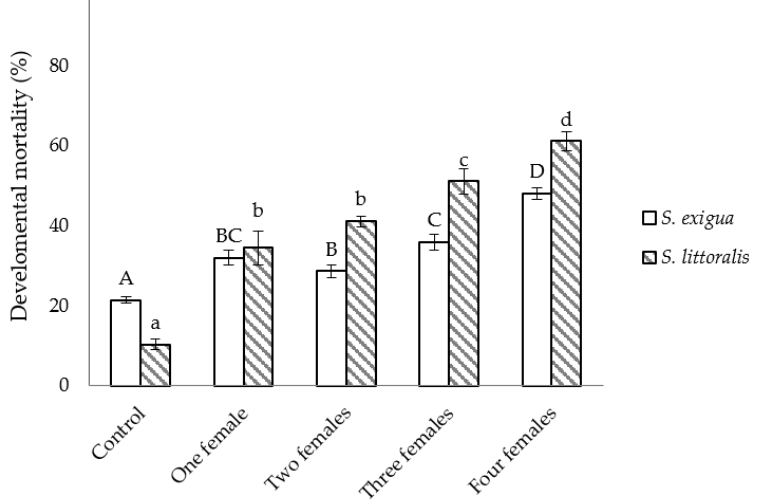
Figure 2. Developmental mortality of Spodoptera inside the greenhouse, depending on the number of Chelonus inanitus females parasitizing simultaneously. Data (mean ± SEM) are percentages, according to the 60 host eggs offered to the parasitoid. Letters stand for significant differences among treatments ( p < 0.05).